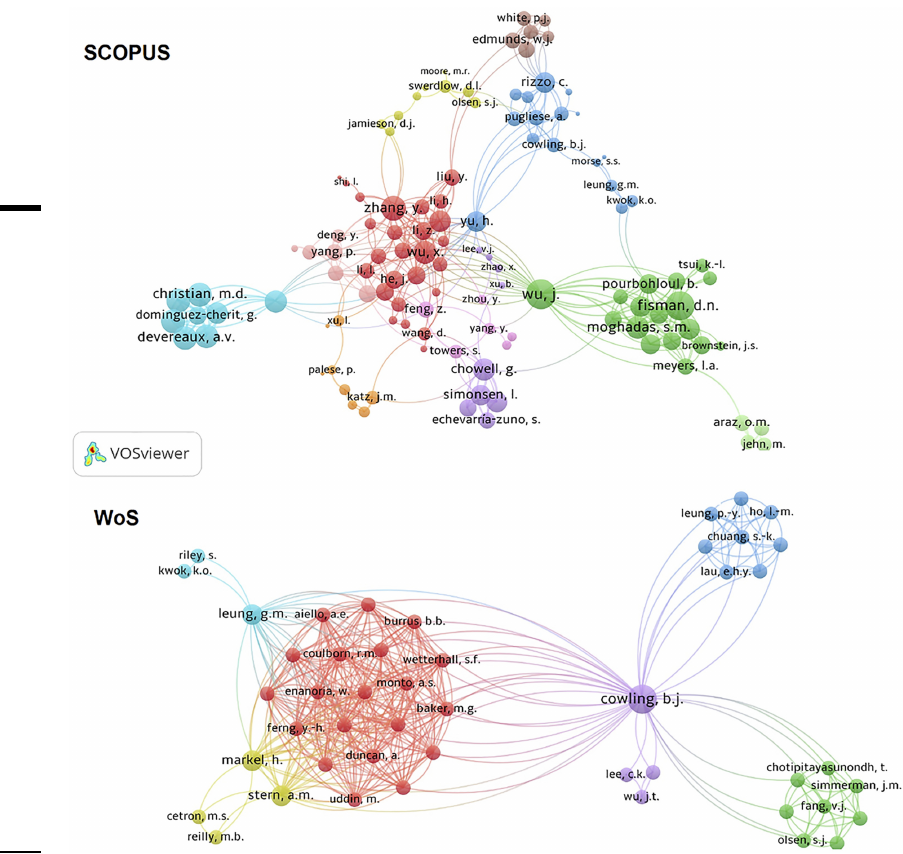
Figure 5a is an integrated step-by-step protocol for monitoring and controlling any pandemic